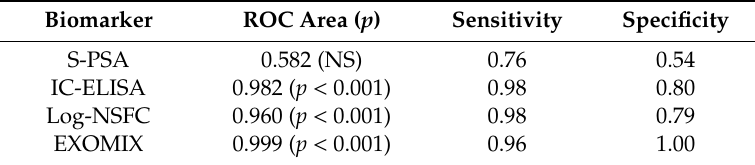
Table 1. ROC Analysis of Di ff erent